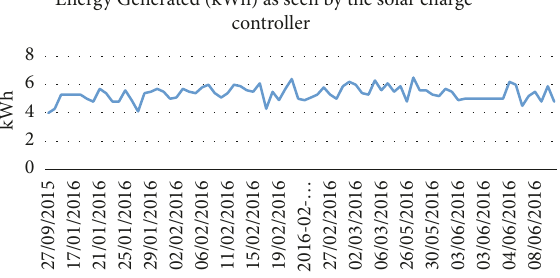
Figure 5: Daily energy generated (81-day observation).